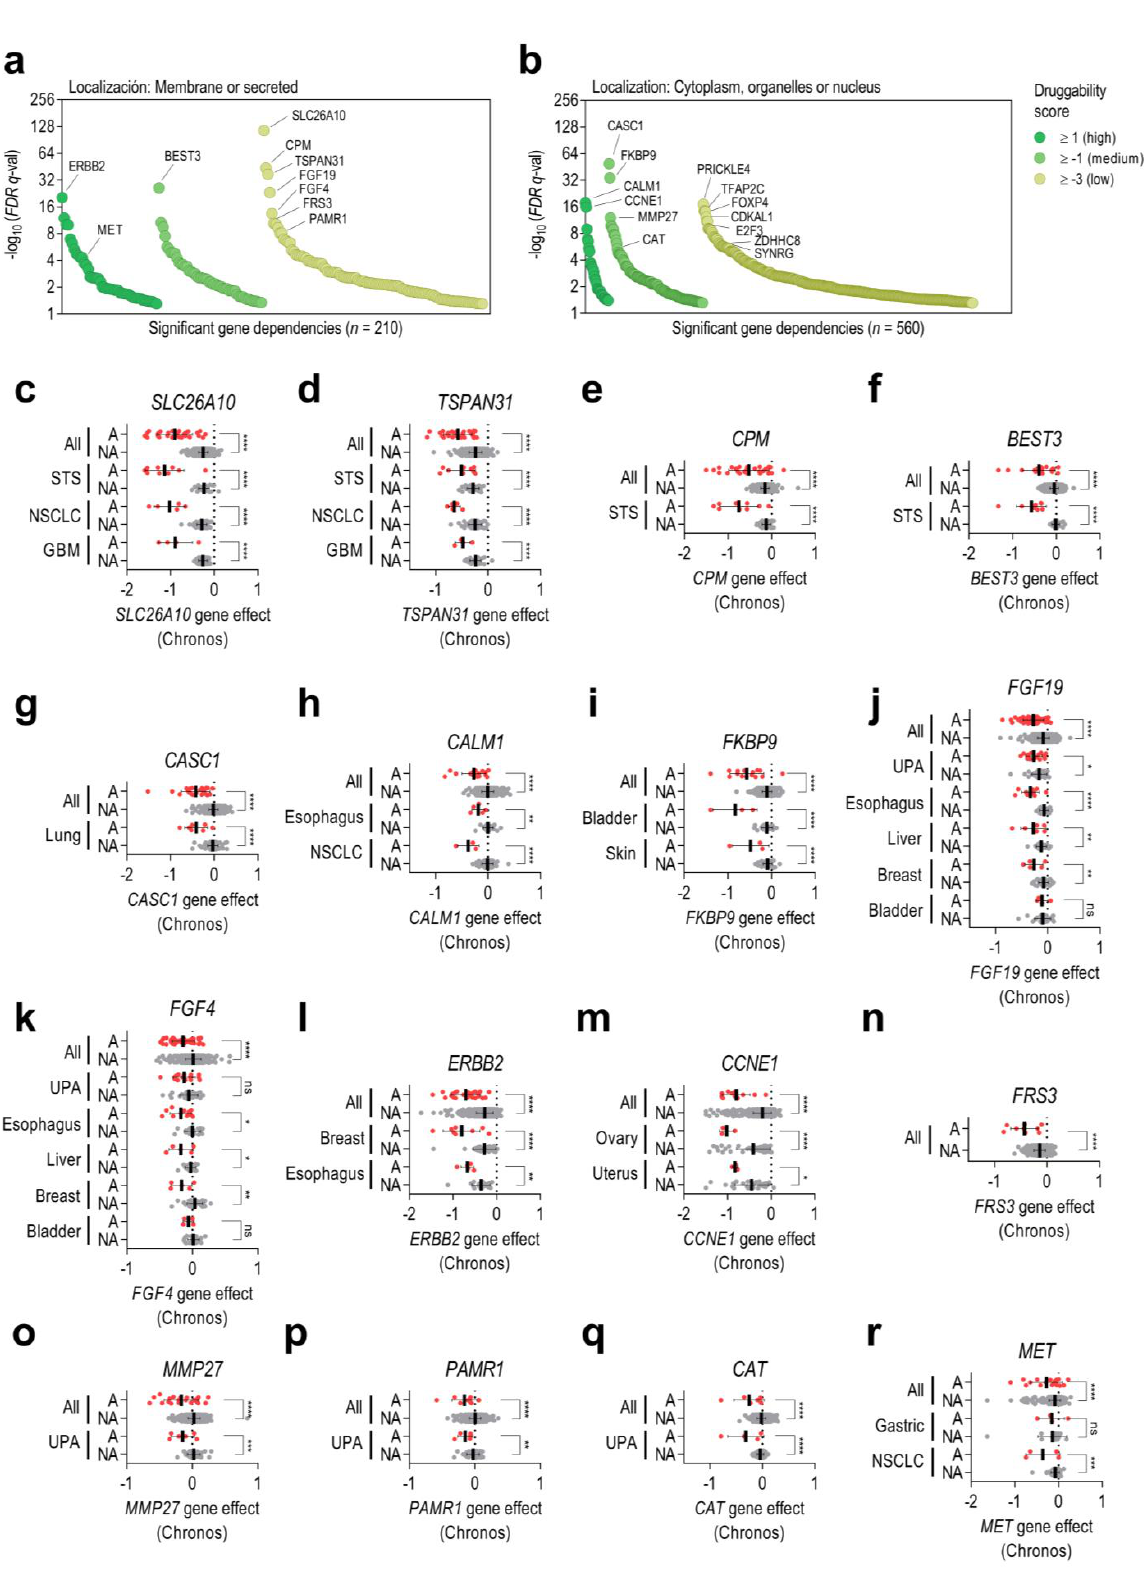
Figure 3. Prioritization of candidate targets for each chromosome amplification. CanSAR druggability scores (from +3 to − 3) were integrated for all significant dependent genes previously identified. A higher druggability score indicates a higher probability of the codified protein harboring ligandable pockets within its 3D structure. Dependent genes were classified as ( a ) genes codifying for membrane or secreted proteins or ( b ) genes codifying for proteins located in the cytoplasm, organelles, or